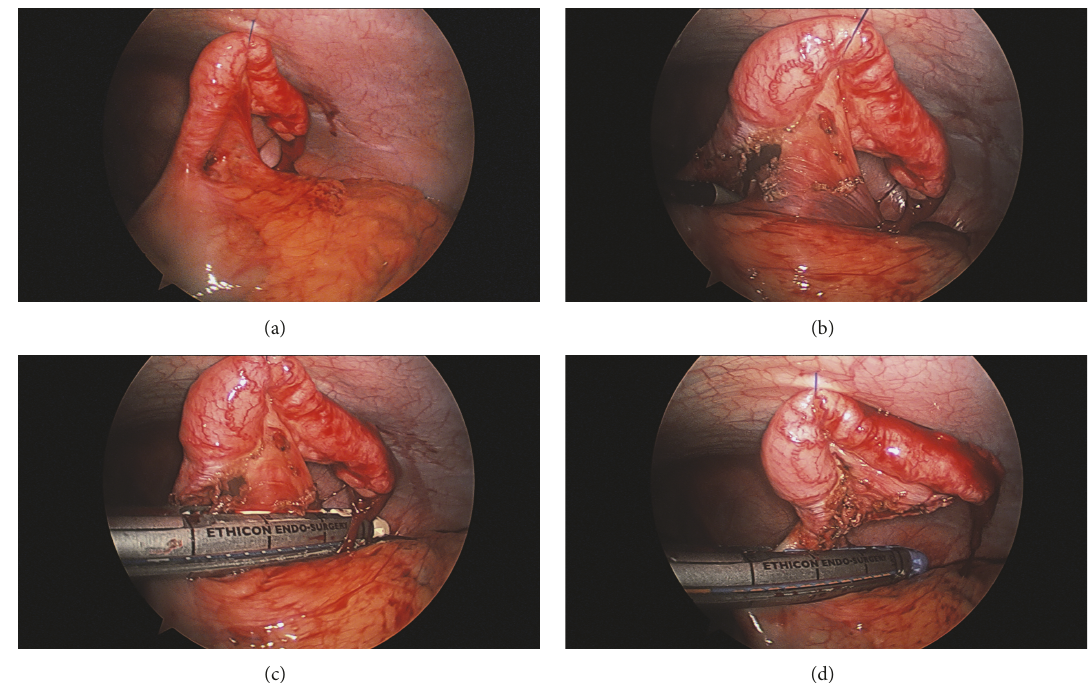
Figure 4: (a) The appendix is suspended to the abdominal wall using a Keith needle suture. (b) A window is created between appendix and mesoappendix. (c) The vascular pedicle is stapled. (d) The appendix is stapled at the